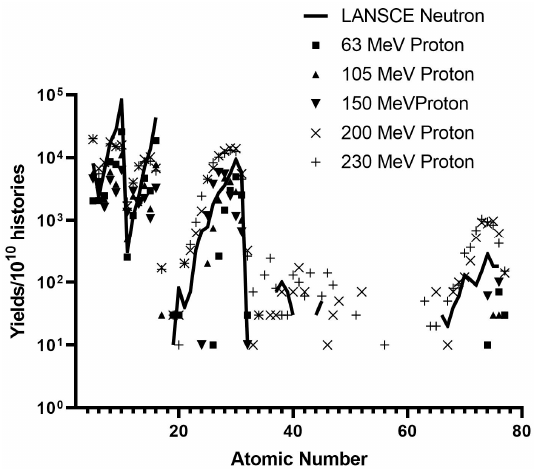
Figure 6. The secondary particle yields in structure without SiGe irradiated by 63, 105, 150, 200, and 230 MeV protons and LANSCE neutron.